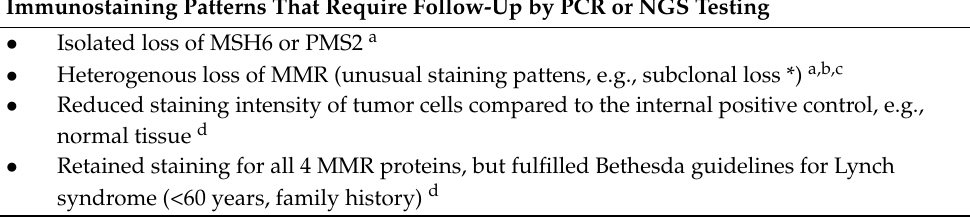
Table 2. Indications for PCR or NGS testing to determine MSI